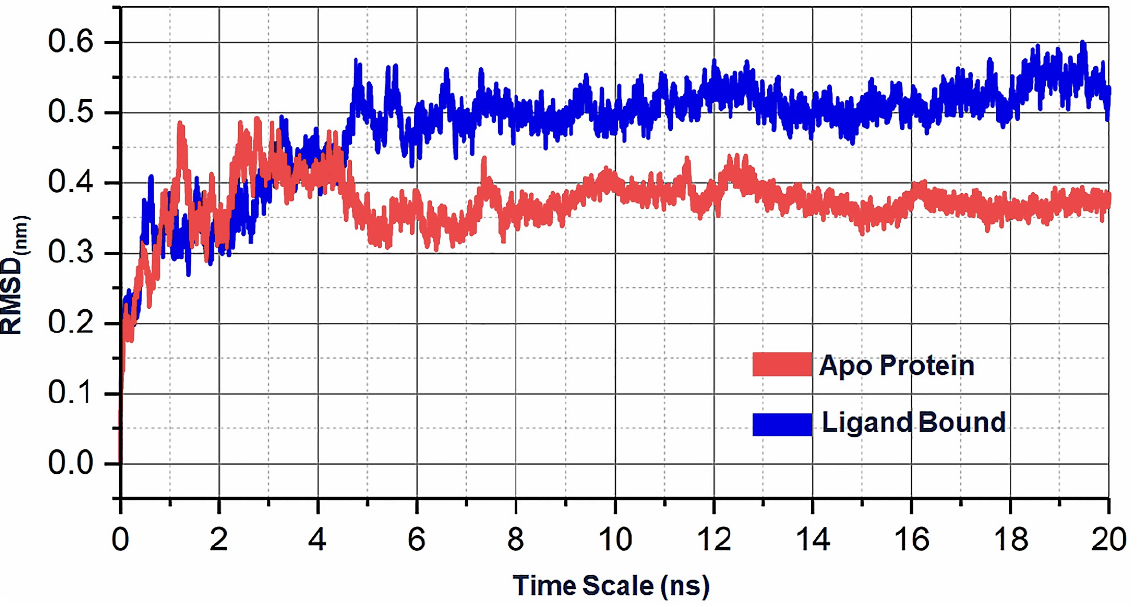
Figure 13. RMSD chart showing a representation of the deviation that occurred within 20 ns in reference to the initial structure for both apo (red) and holo (blue) forms.